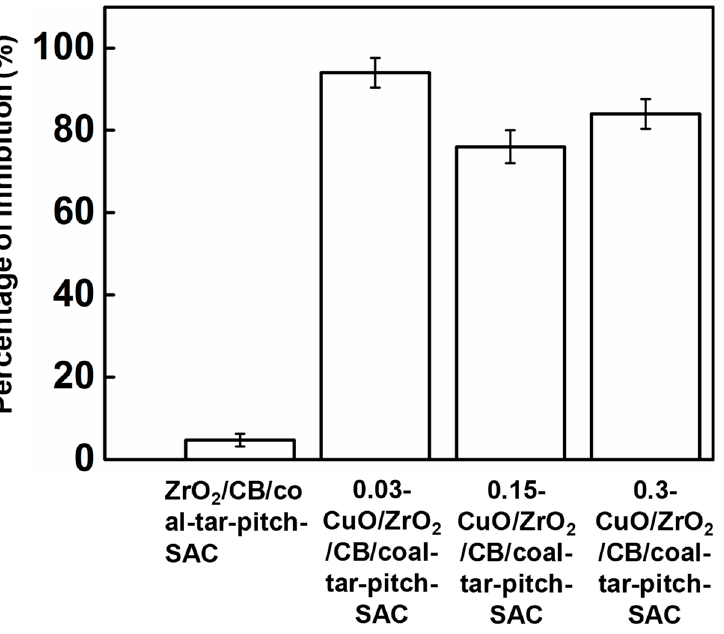
Figure 9. The sterilization effects of ZrO 2 /CB/coal-tar-pitch-SAC and CuO/ZrO 2 /CB/coal-tar-pitch- SAC materials.